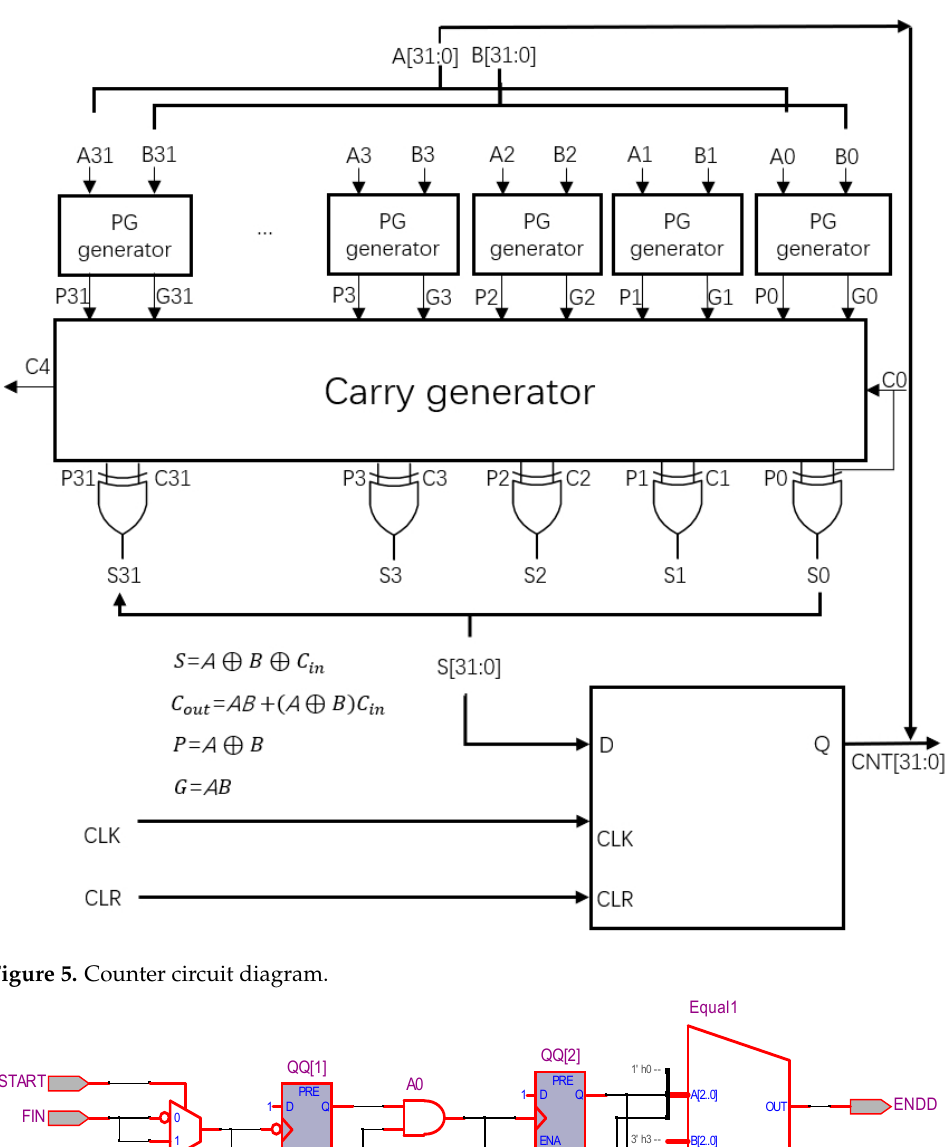
Figure 5. Counter circuit diagram.